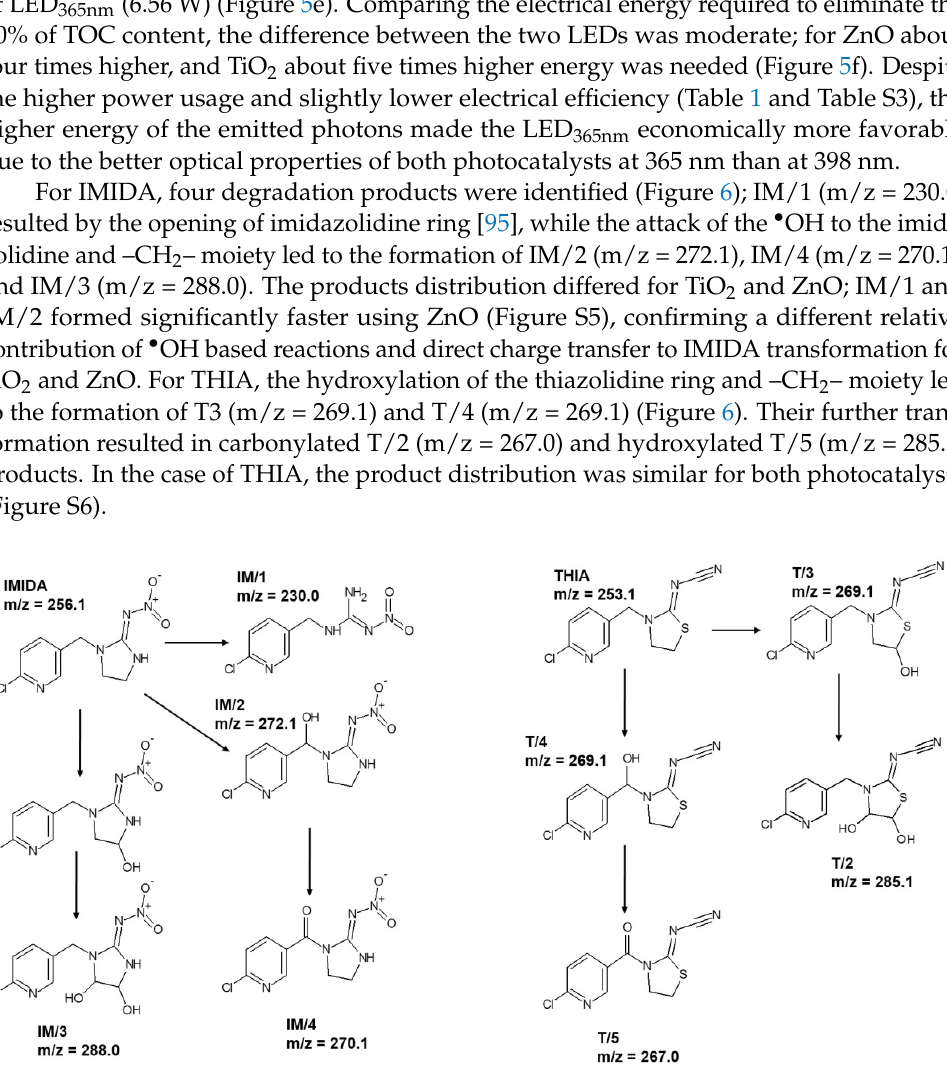
Figure 6. The products of IMIDA and THIA detected by HPLC-MS.